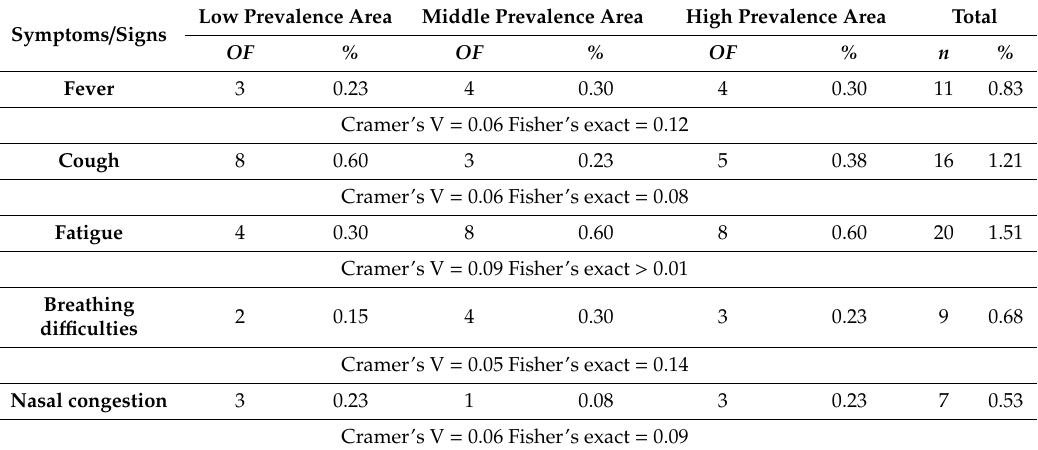
Table 1. Prevalence of symptoms / signs related to the COVID-19 in the di ff erent Swiss cantons and the Principality of Liechtenstein sorted after COVID-19 prevalence level. Percentages were calculated per